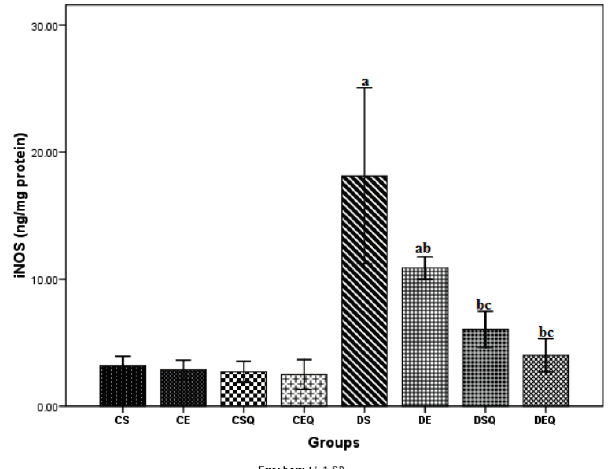
Figure 6. The effects of quercetin and moderate exercise training on the level of inducible nitric oxide synthase (iNOS) (ng/mg protein) in the thoracic aortic tissue homogenates of control and diabetic rats. Results are the means ± SD for ten animals each group, defined as in the caption of Figure 1. Statistically significant differences are indicated by the symbols: a p < 0.05 vs. CS group, b p < 0.05 vs. DS group and c p < 0.05 vs. DE group.